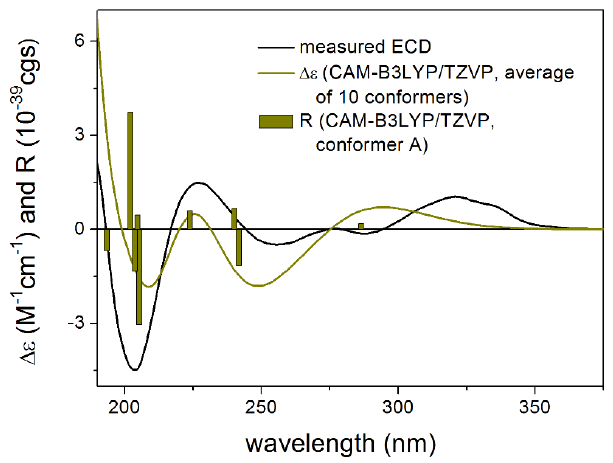
Figure 8. Comparison of the experimental ECD spectrum of 4 measured in MeCN with the CAM-B3LYP/TZVP PCM/MeCN spectrum of (6 R ,7 S ,8 S ,9 R ,10 R )- 4 (level of optimization: CAM-B3LYP/TZVP PCM/MeCN). The bars represent the rotational strength values of the lowest energy conformer.